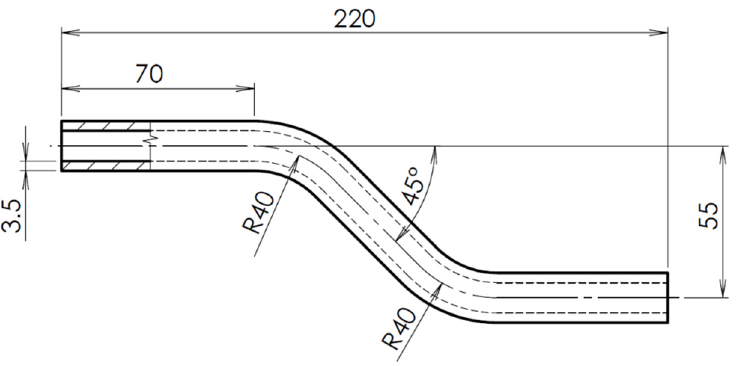
Figure 1. Design of an off-axis hollow CFRP profile.